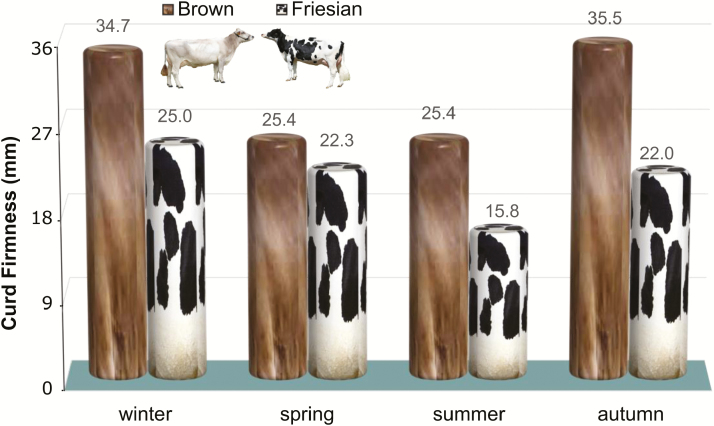
Seasonal trends of curd firmness (millimeter) of Friesian and Brown herd milk (Malacarne et al., 2005).